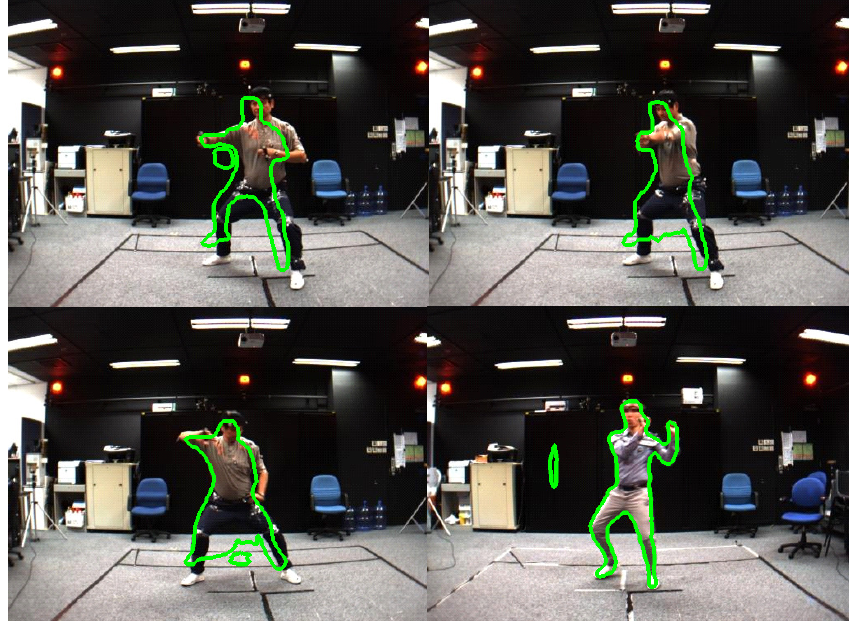
Figure 11. Examples of false human segmentation results on the MADS